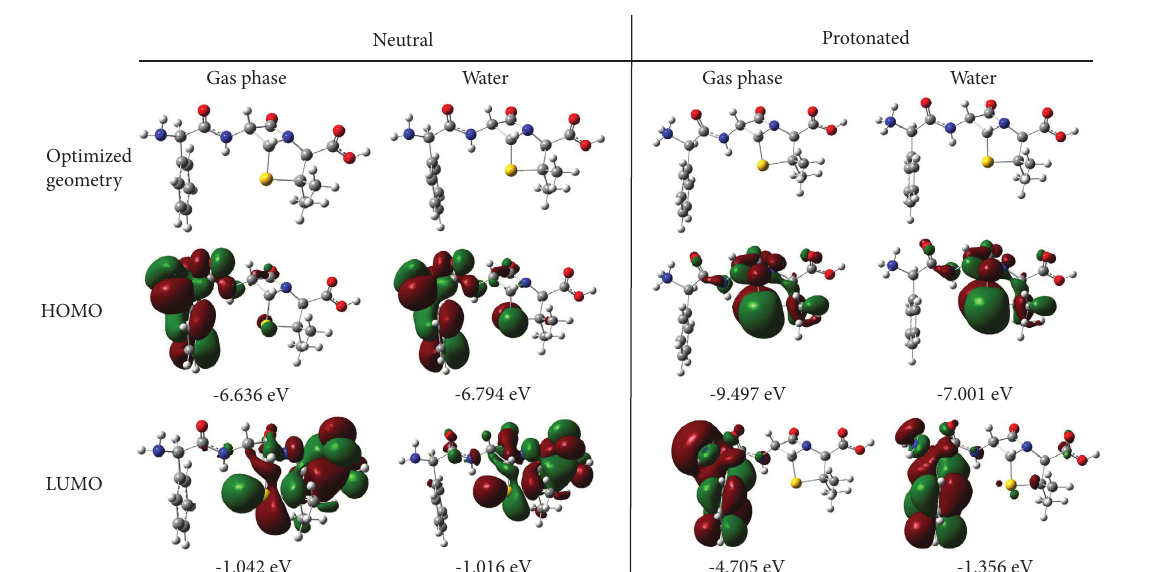
Figure 7: Optimized molecular geometry and frontier molecular orbitals (HOMO and LUMO) of AMP inhibitor following both neutral and protonated